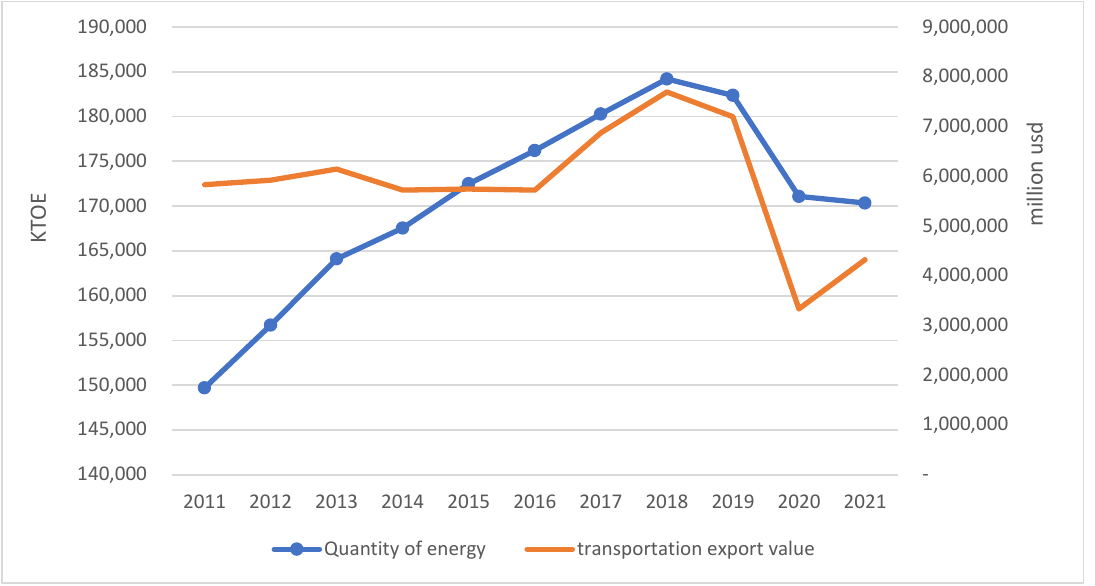
Fig. 1. Trend of the energy consumption and transportation export value of